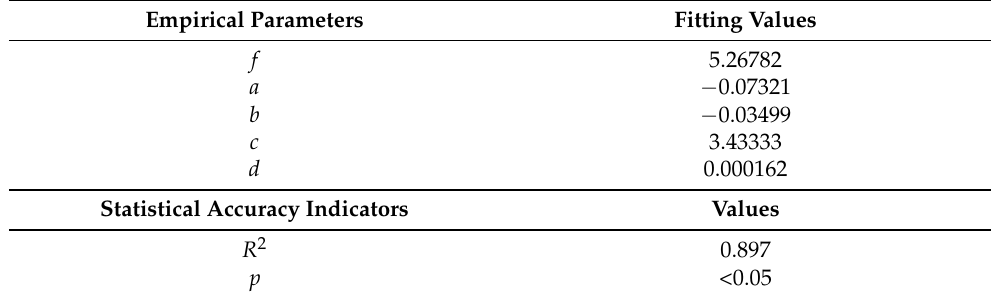
Table 2. Fitting parameters to predict Nu from Ha number and inclination angle θ at Ra = 10 5 .